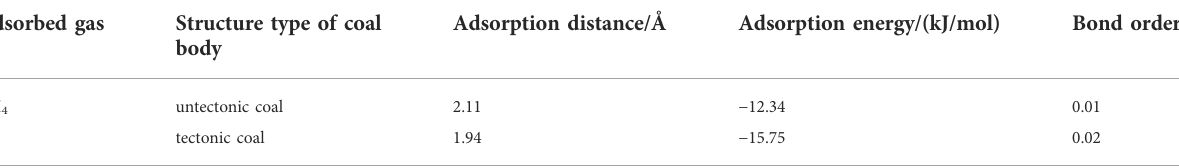
TABLE 3 Gas and different types of coal adsorption distance, adsorption energy and bond order (modi fi ed from Wang et al., 2009). Adsorbed gas